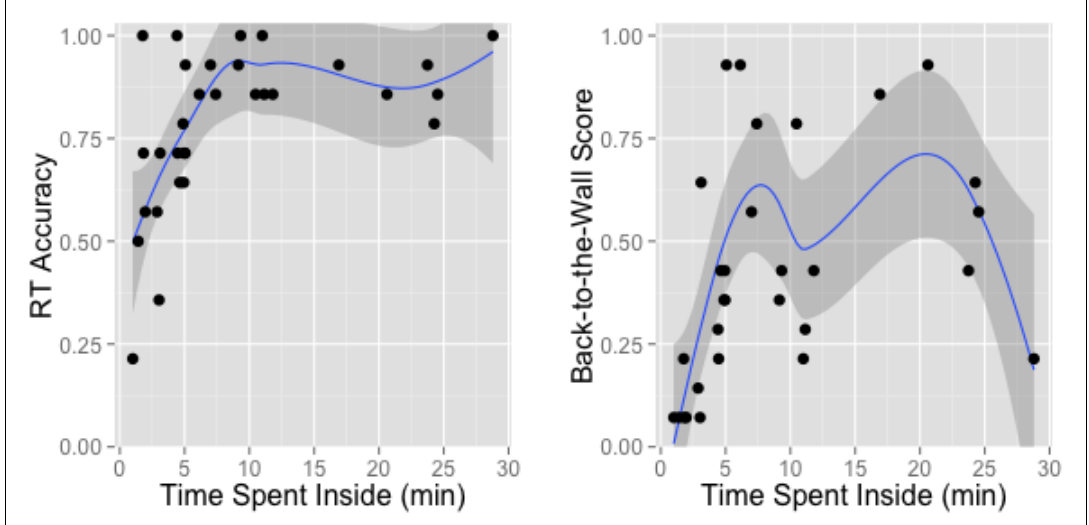
Figure 7. The influence of time spent inside on the personal means of RT accuracy and Back-to-the-Wall score